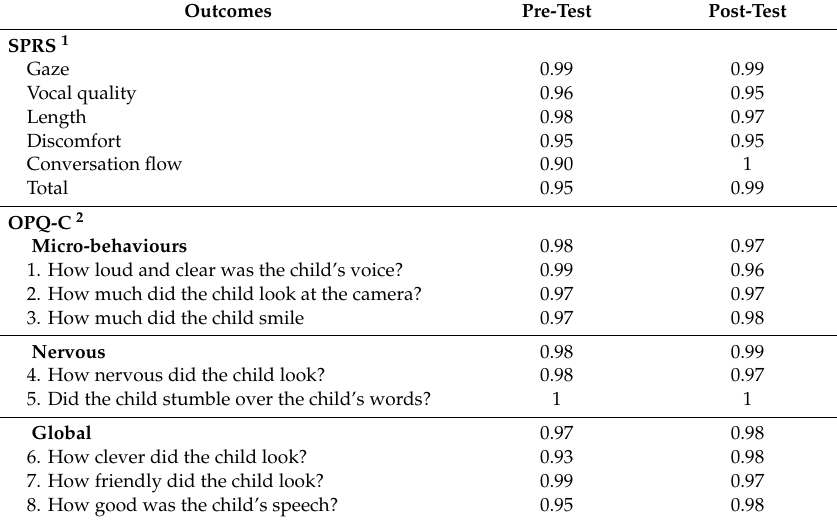
Table 1. Spearman correlations for inter-judge